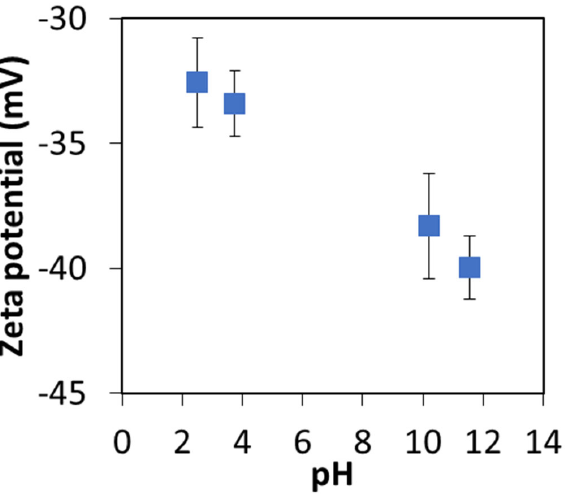
Figure 5. The zeta potential values of GO powders in aqueous media at different pH values.